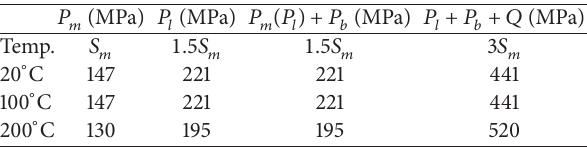
Table 3: Design criterion of mechanical strength.